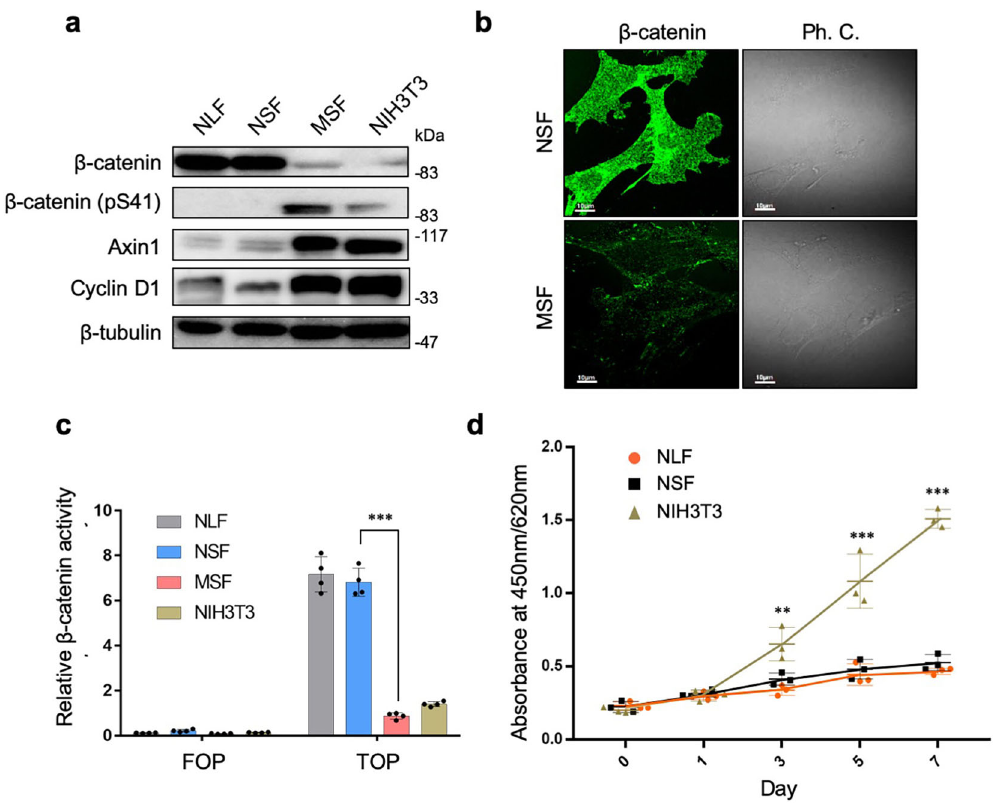
Fig. 1 Unique activation of β -catenin signaling in NMR cells. a Representative immunoblots comparing expression of β -catenin and its downstream targets in NMR lung fi broblasts (NLFs), NMR skin fi broblasts (NSFs), mouse fi broblasts (MSFs), and NIH 3T3 cells. b Representative images of immuno fl uorescence staining of β -catenin in NSFs and MSFs. In the phase-contrast images, unknown microbodies are abundant in NSFs. c TOPFLASH reporter assay showing signi fi cant differences in relative β -catenin activity between NLFs, NSFs, and NIH 3T3 cells. d The proliferation rates of NSFs, NLFs, and NIH 3T3 cells were determined in a growth assay conducted for 7 days. Data presented in c, d are expressed as the mean ± standard deviation; *** p < 0.001, two-sided Student ’ s t